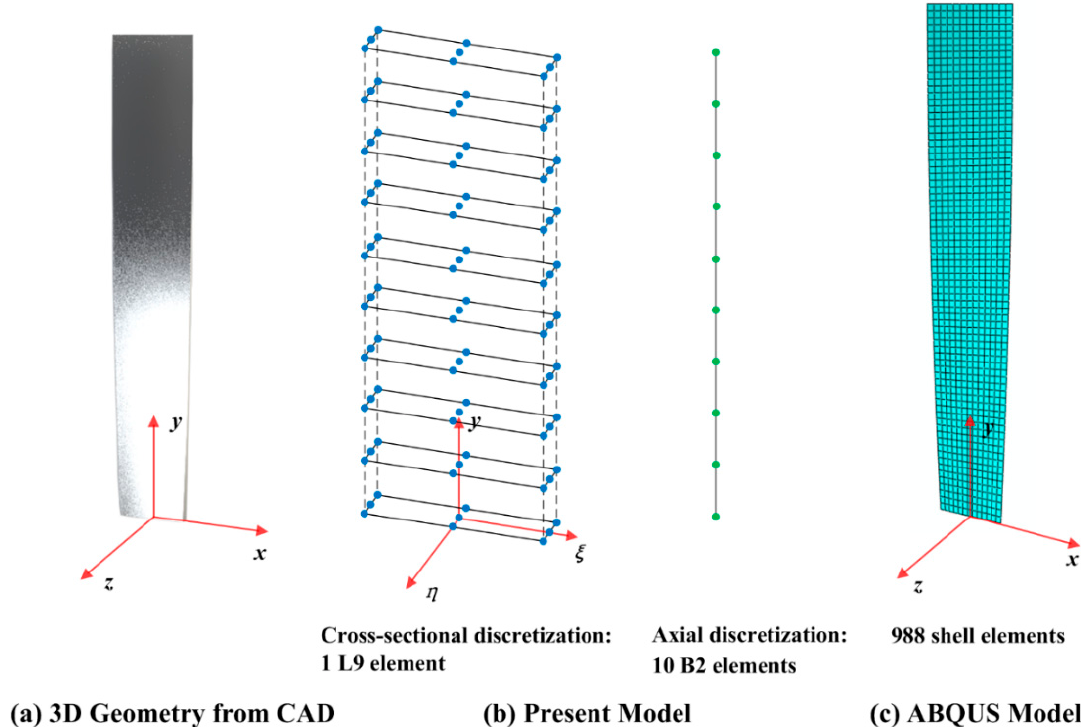
Figure 5. Geometries of a pre-twisted cantilever with rectangular cross section and remarkable difference in discretization between the present model and ABAQUS model: ( a ) 3D geometries from CAD in ( e x , e y , e z ), ( b ) 1 L9 element for cross-sectional discretization and 10 2-node beam (B2) elements for axial discretization based on current formulations in ( e ξ , e y , e η ), and ( c ) converged 988 shell elements from ABAQUS in ( e x , e y , e z ).